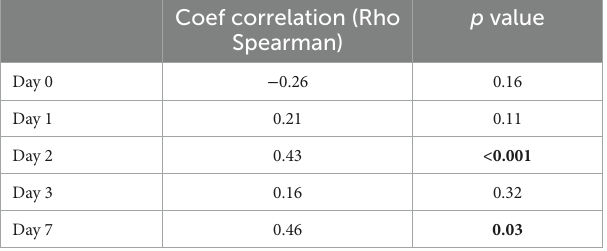
TABLE 6 Correlation of IL-10 with CRP.